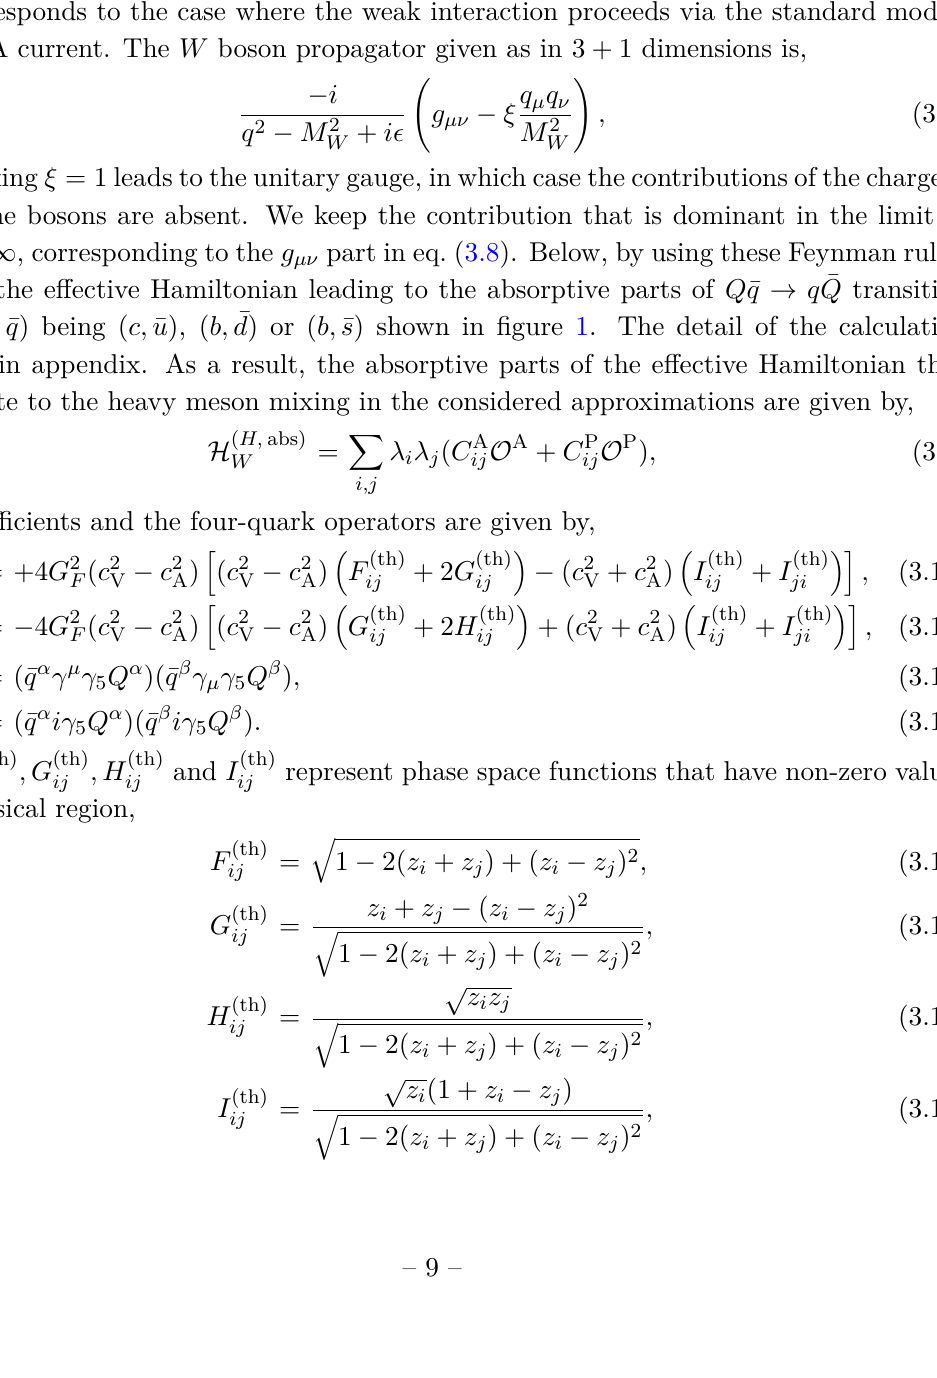
Figure 1 . Partonic processes of Q ¯ q → q type (up-type) quarks for the former (latter). Only shown are color flows, and the W bosons are